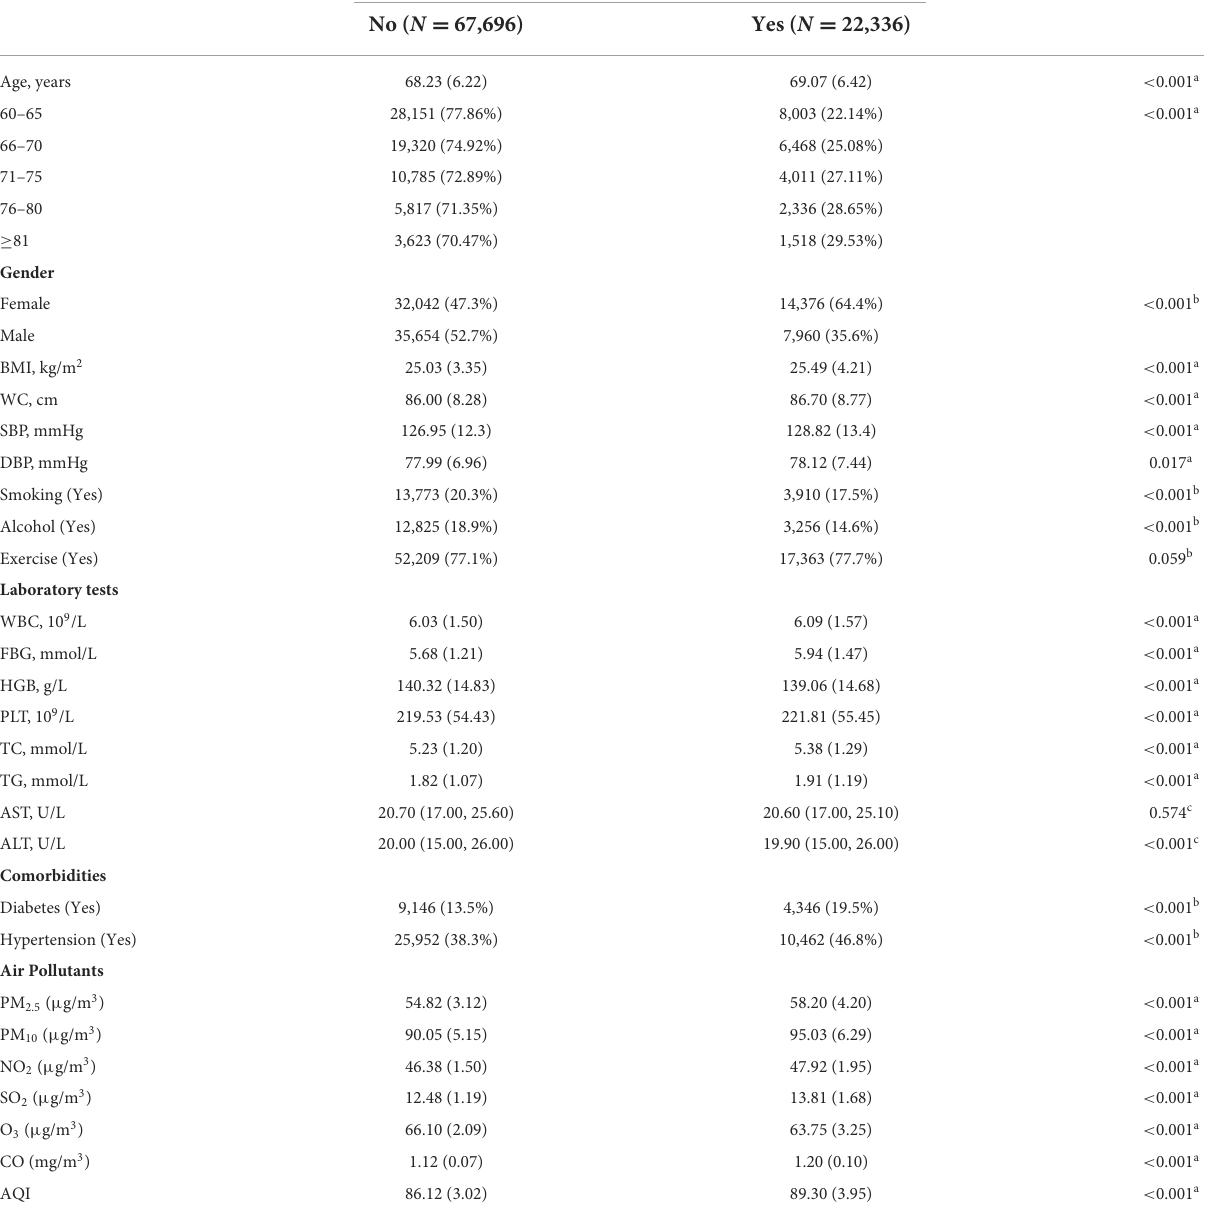
TABLE 1 Baseline characteristics of participants in this